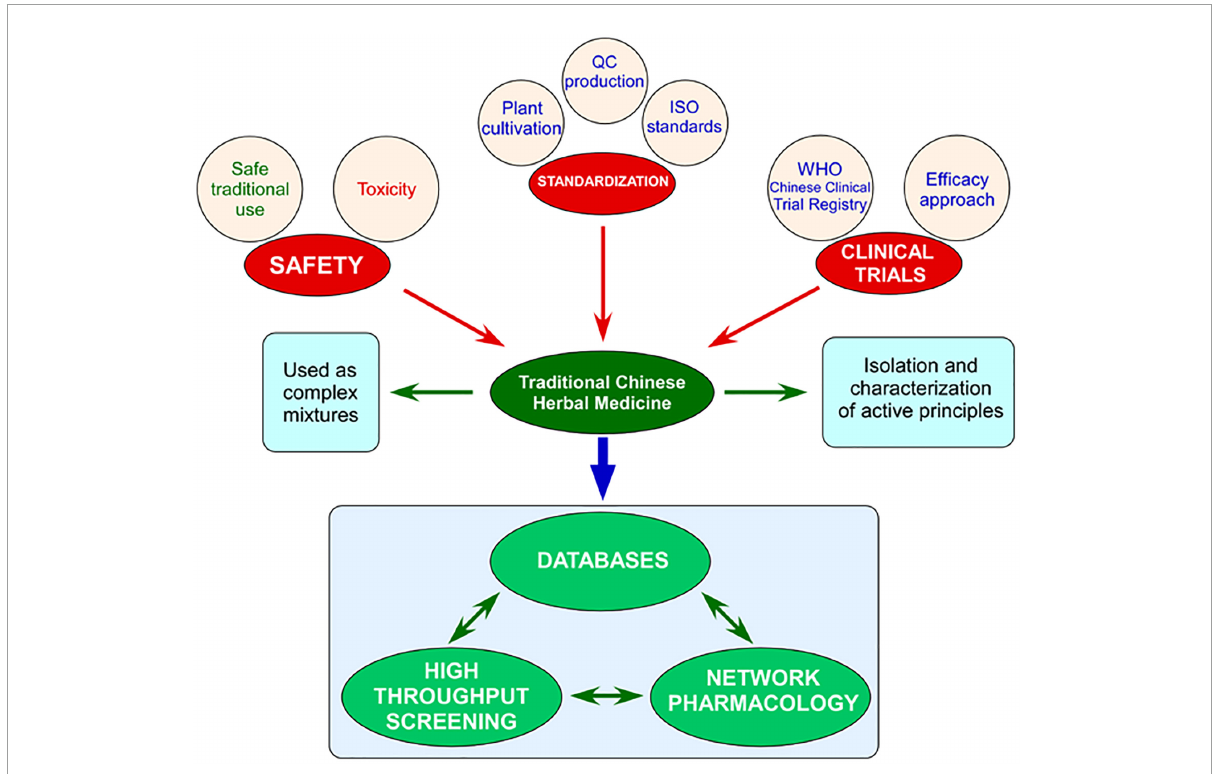
FIGURE1 Schematic representation of the main bottlenecks impeding the modernization of Traditional Chinese medicine (TCM) and its incorporation into Western medical practice (safety, standardization, and poor clinical trials) and the ways forward provided by the generation of databases of preparations, compounds, targets; high throughput screening; and network